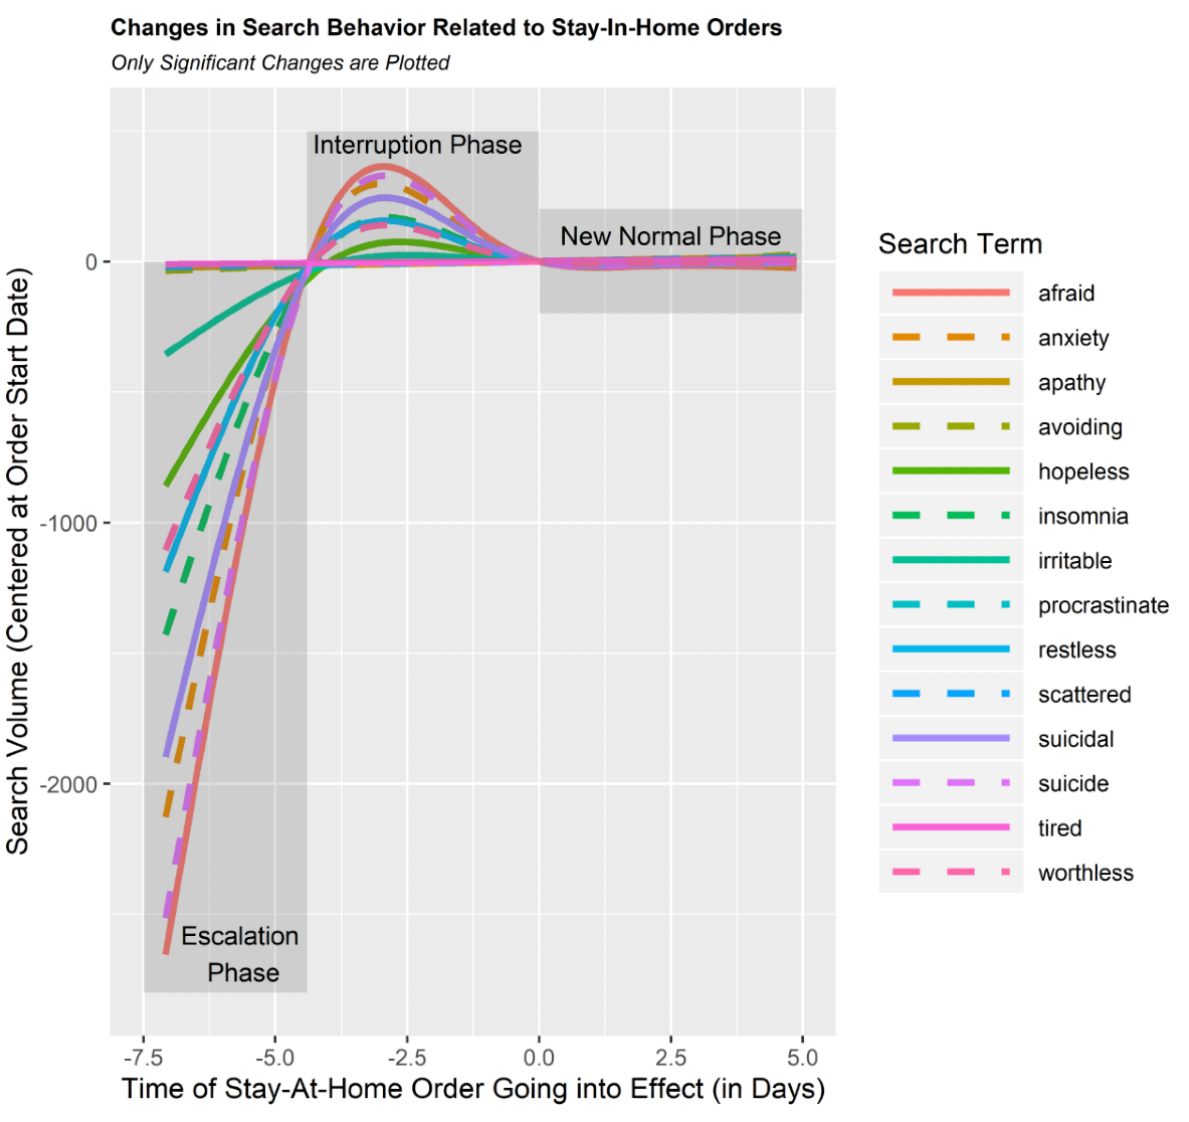
Figure 3. This plot depicts the changes in search patterns relative to the orders going into effect. Negative time of stay-at-home values reflects the time before the stay-at-home orders go into effect, and positive values reflect the time following the order going into effect. Note that in this plot, the predictions are not normalized to show the magnitude of the effects. The centering performed here subtracts the actual value at 0 from the estimates of this term. The escalation phase designates approximately 4 days prior to the stay-at-home orders going into effect. The interruption phase spans between approximately 4 days and 0 days before the orders go into effect, and the new normal phase represents the times the 5 days after orders go into